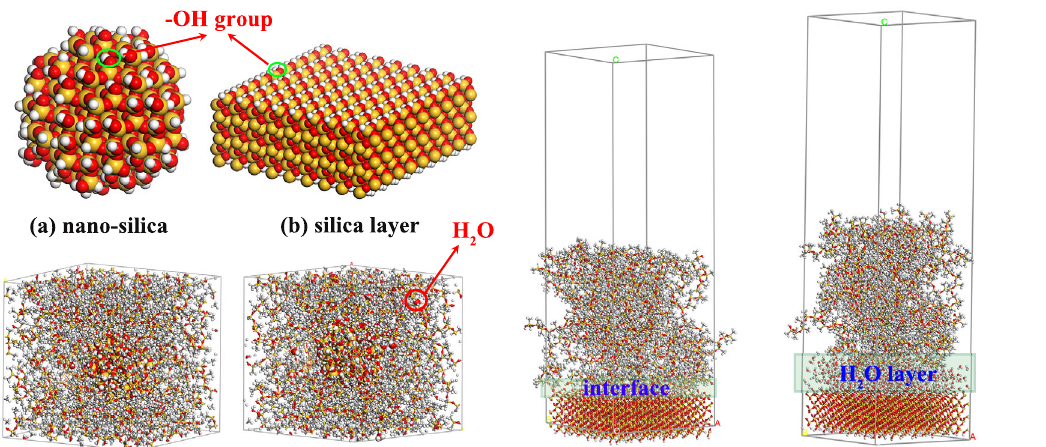
Fig. 16 Construction of nano-silica/PDMS and PDMS-silica interface models. a Molecular structure of nano-silica, b molecular structure of silica layer, c nano-silica/PDMS composite, d nano-silica/H 2 O/PDMS, e silica/PDMS interface, and f silica/H 2 O/PDMS